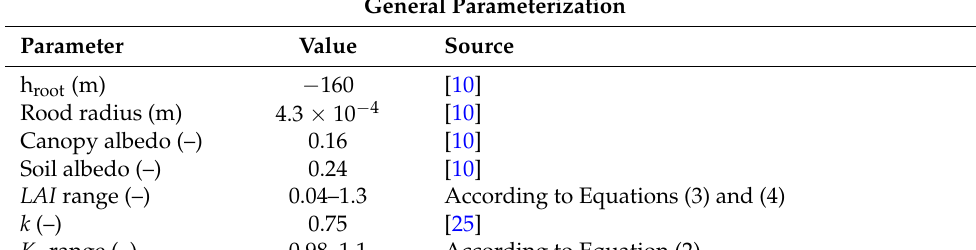
Table 1. Main soil and vegetation parameters for the studied site. General